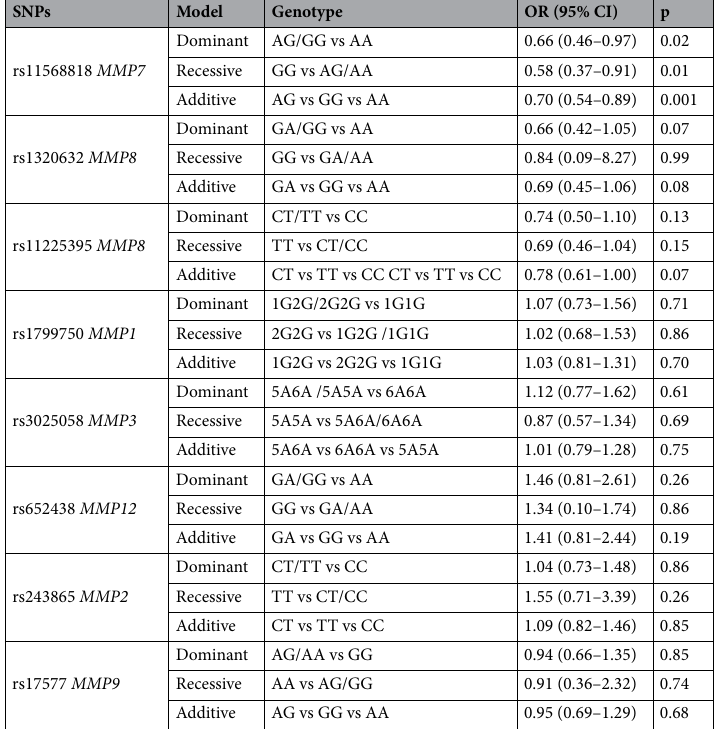
Table 3. Association of the MMPs genotypes with EH. OR odds ratio, 95% CI 95% confidence interval, p significance level.